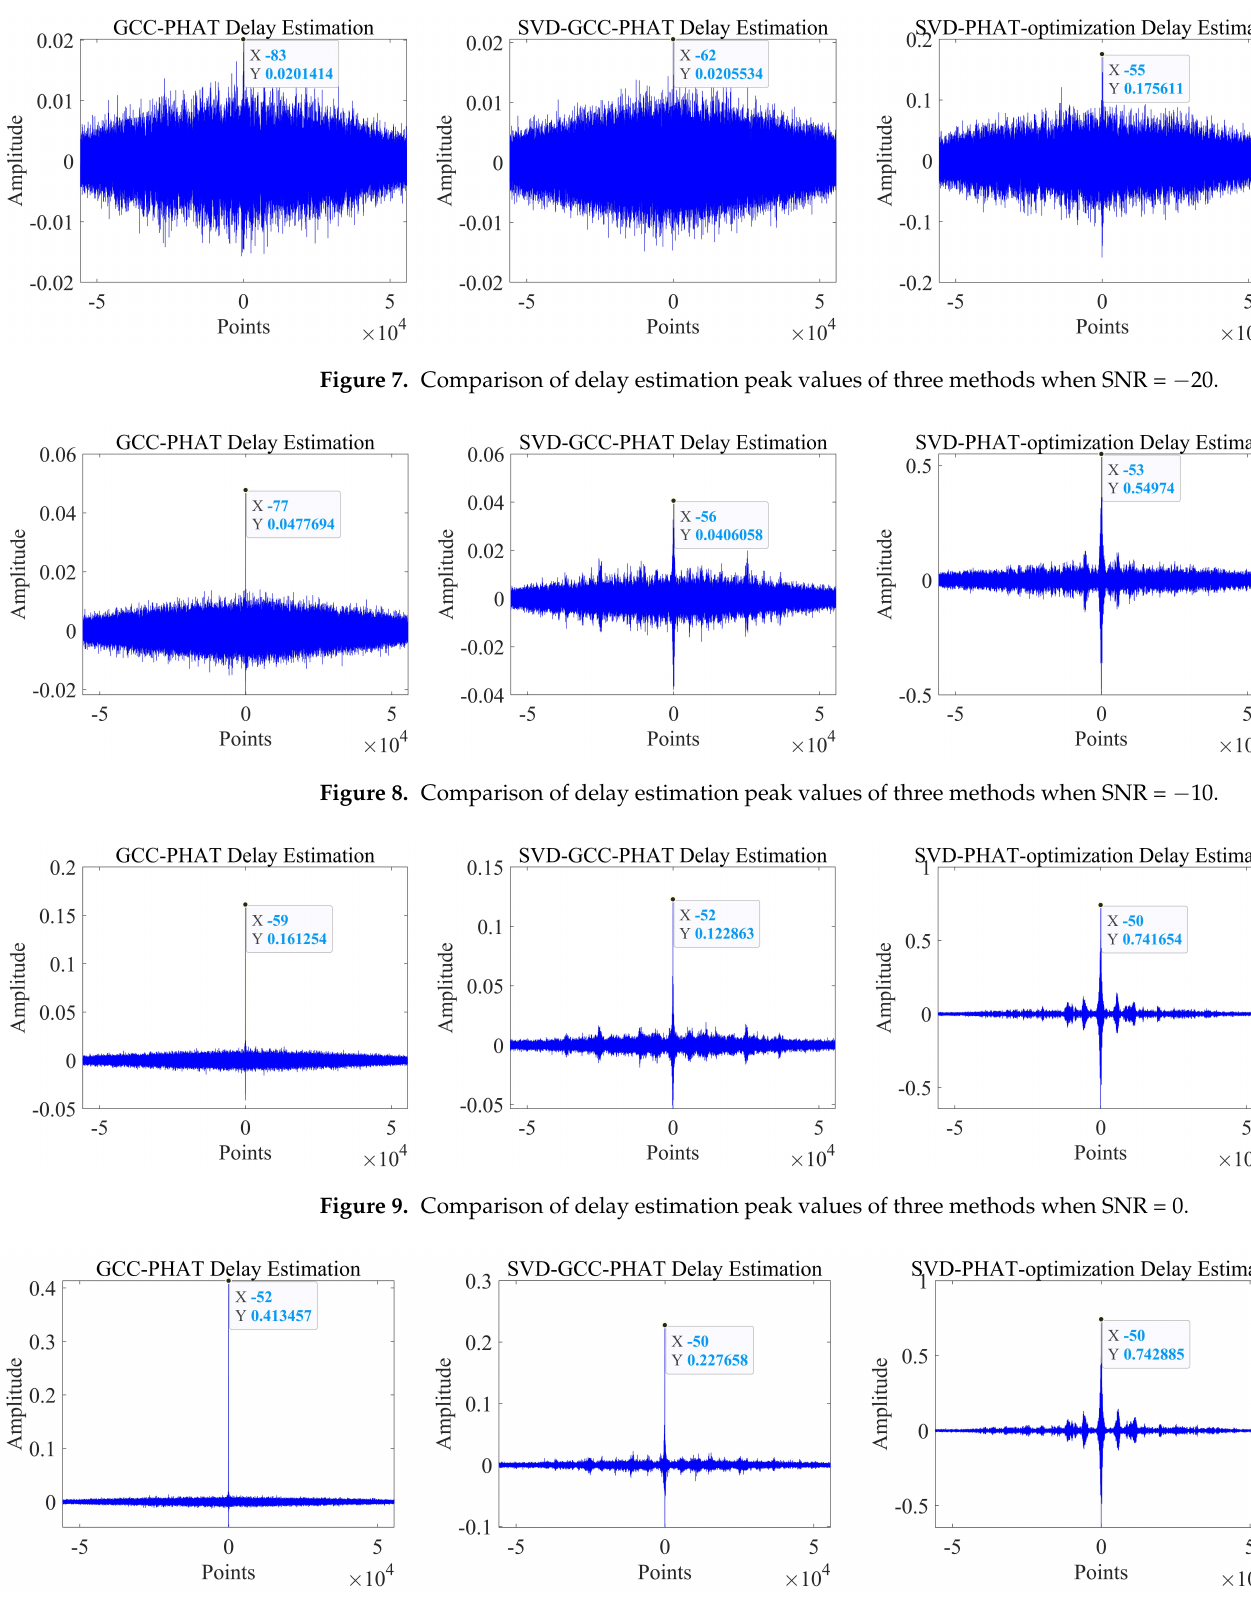
Figure 10. Comparison of delay estimation peak values of three methods when SNR =